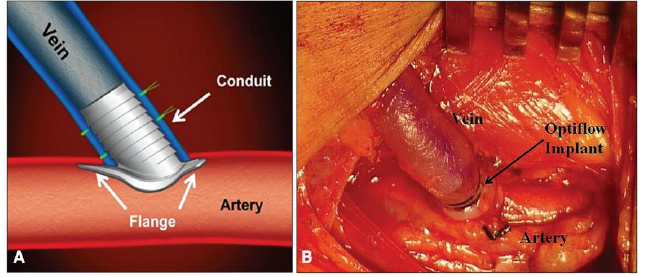
Figure 4. ( A ) The Optiflow device is composed of a flange, a conduit, and platinum bands. ( B ) An in vivo view of the device implanted within the anastomotic region of an AVF. Images are adapted, with permission, from Chemla et al. (2014) [63].